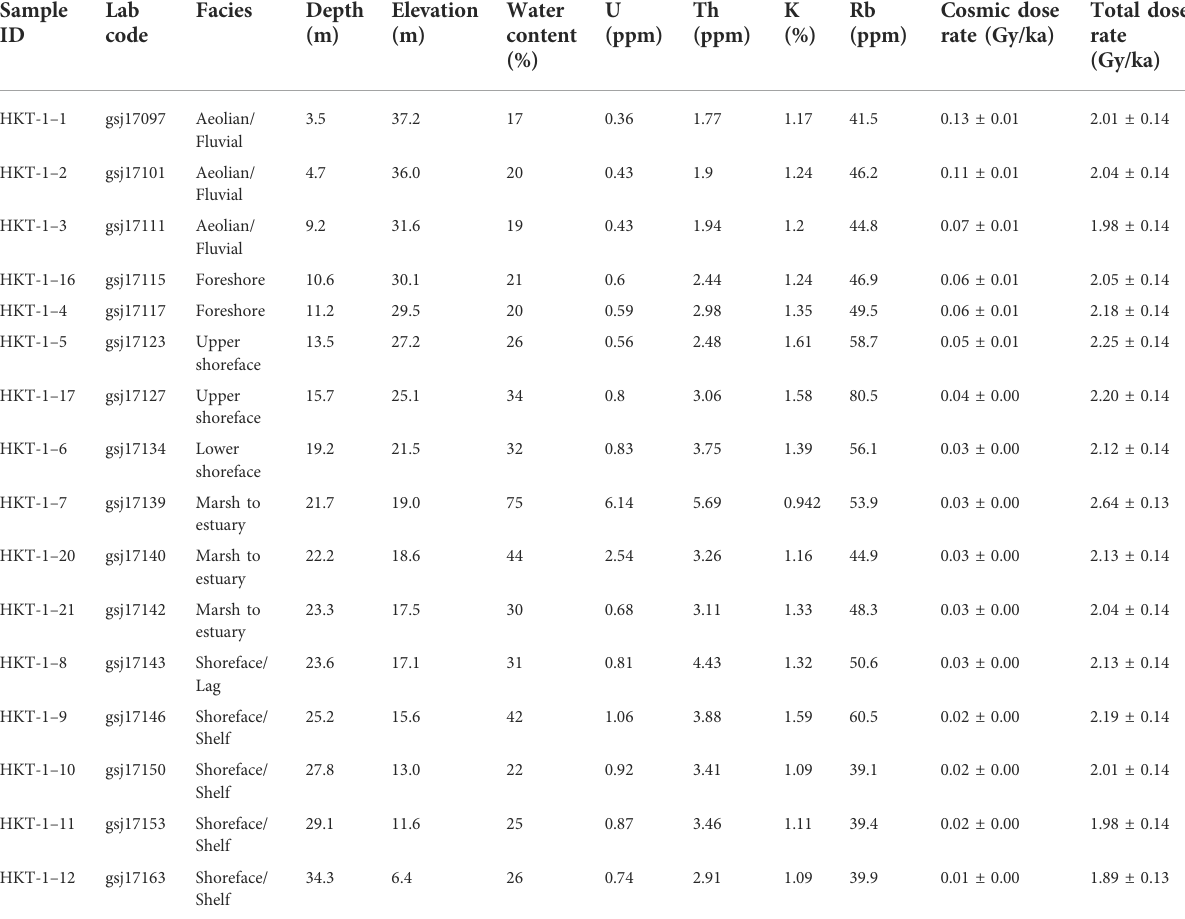
TABLE 1 Details of samples for luminescence dating and estimation of the dose rate.